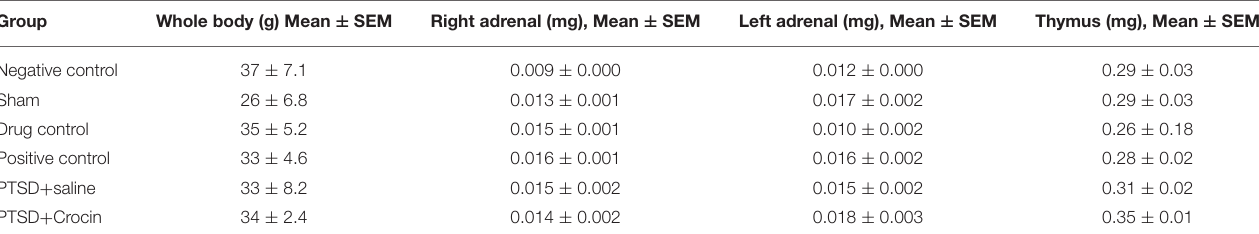
TABLE 3 | Body and tissue weight